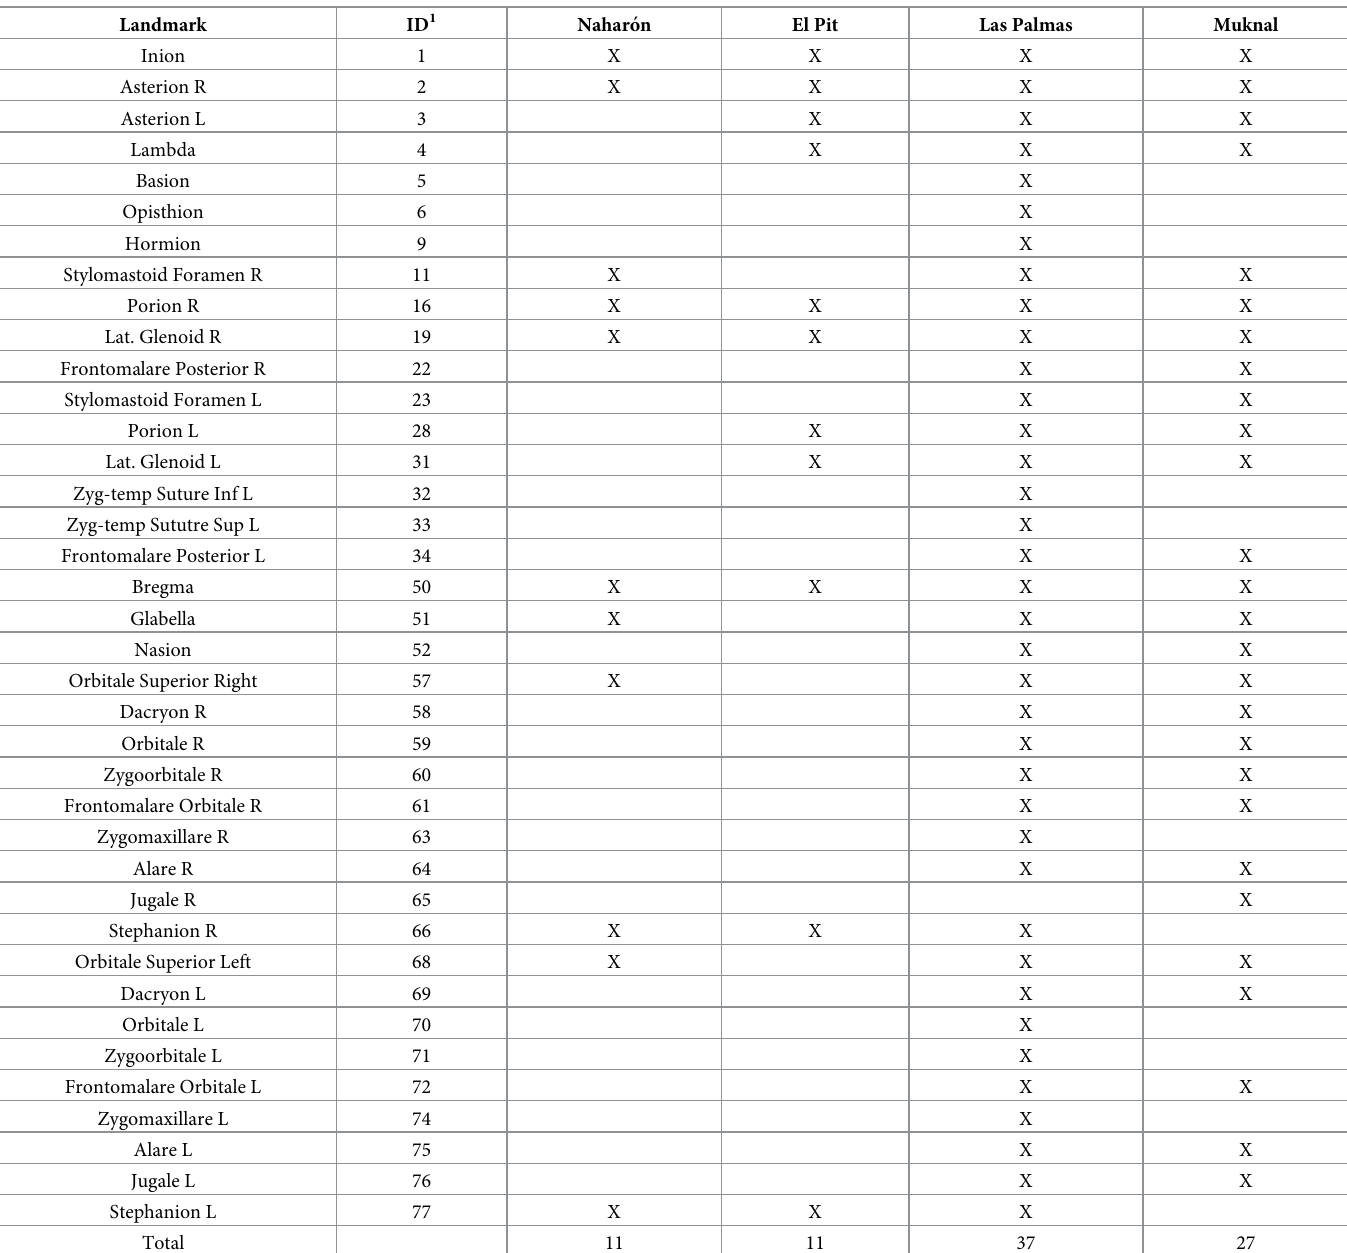
1 –Landmark ID indicates the landmark number for the raw data in S1